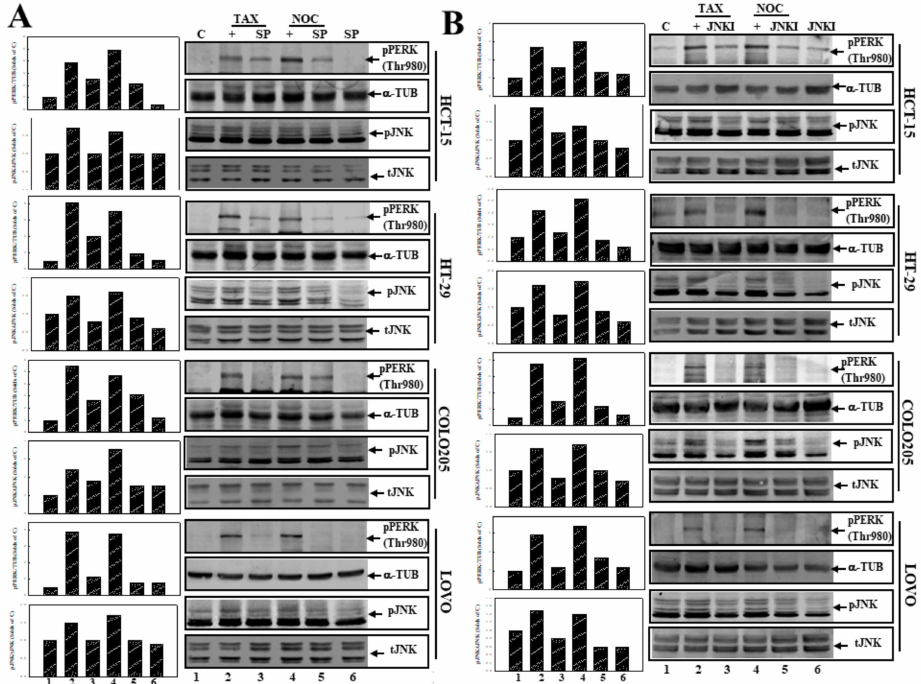
Figure 5. Inhibition of JNK by SP ( A ) or JNKI ( B ) inhibited PERK and JNK protein phosphorylation by TAX and NOC in human CRC cells. Cells were treated SP or JNKI (10 µ M) for 30 min followed by TAX or NOC (10 µ M) stimulation for 12 h. Expressions of pPERK (Thr980), pJNK, total JNK, and α -TUB proteins were examined by Western blotting using specific antibodies. (Right panel) Western blotting. (Left panel) The relative levels of pPERK (Thr980) and pJNK were normalized to α -TUB and tJNK, respectively, and quantified using Image J software